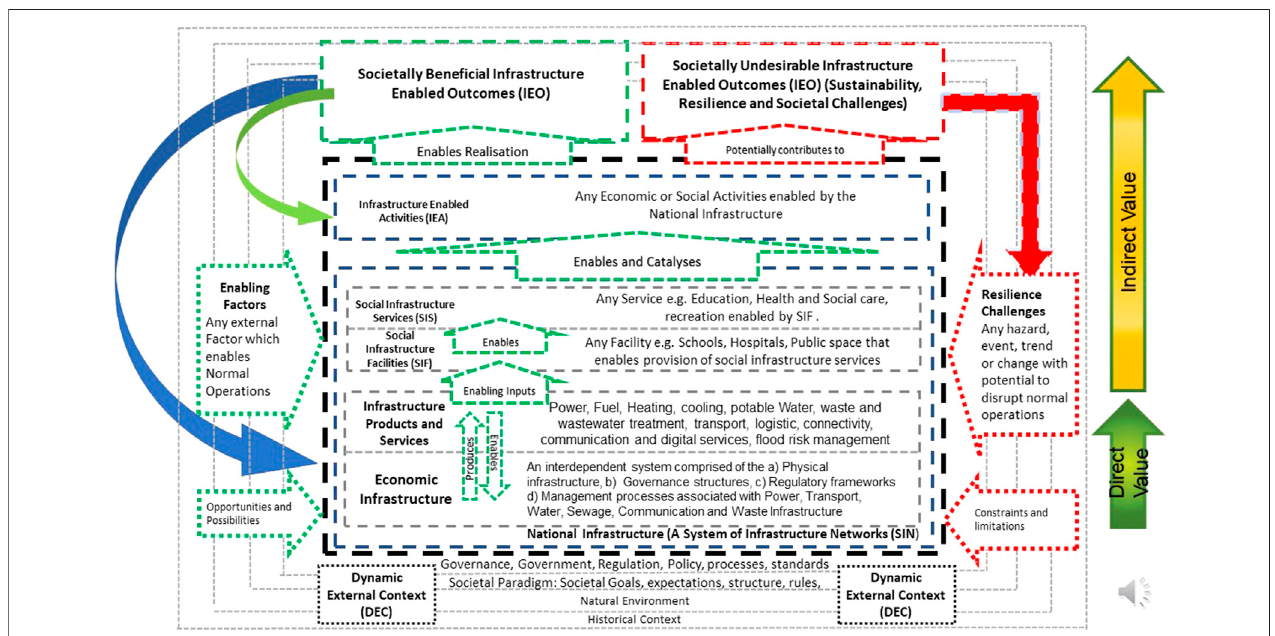
FIGURE 1 | Systemic characterisation of national